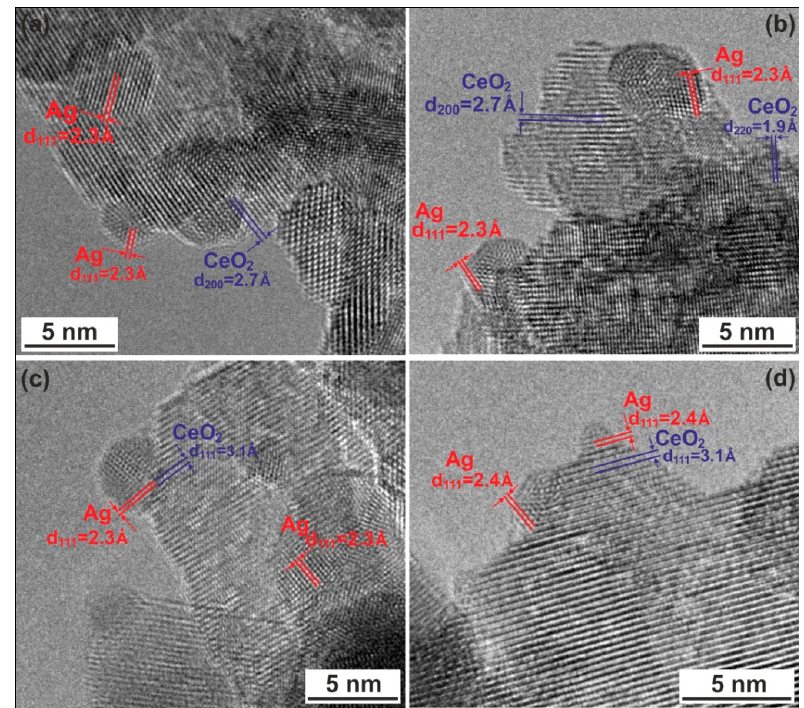
Figure 4. The HR TEM images for Ag/CeO 2 ( a , b ) and Ag/CeO 2 (red) ( c , d ) catalysts.